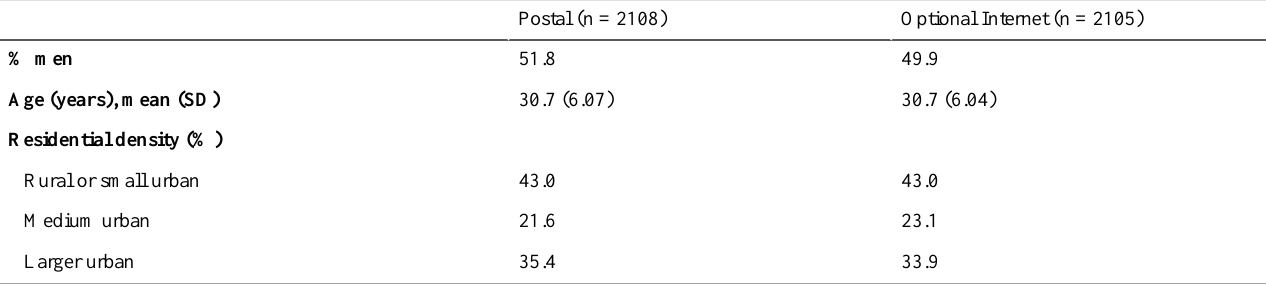
Table 1. Comparison of randomized arms by age, gender, and population density of municipality of